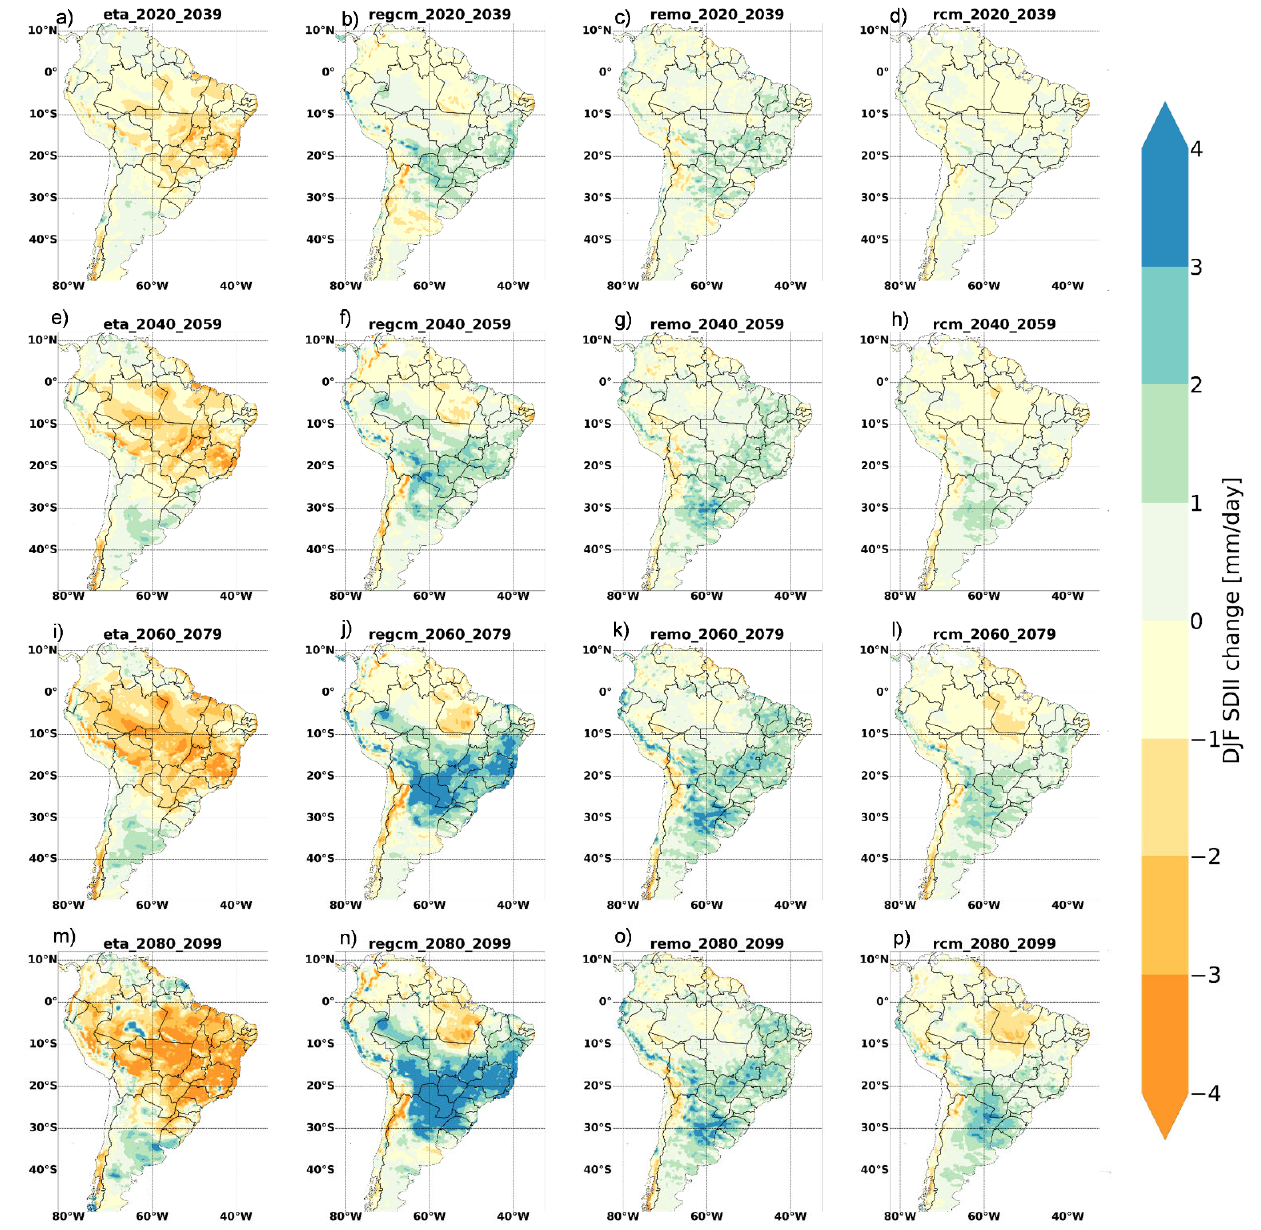
Figure 5. Changes projected to SDII (mm/day) during austral summer computed from each RCM ensemble (Eta, RegCM, and REMO) and 3RCMs ensemble (right column) and considering four time-slices: ( a – d ) 2020–2039, ( e – h ) 2040–2059, ( i – l ) 2060–2079, and ( m – p ) 2080–2099.